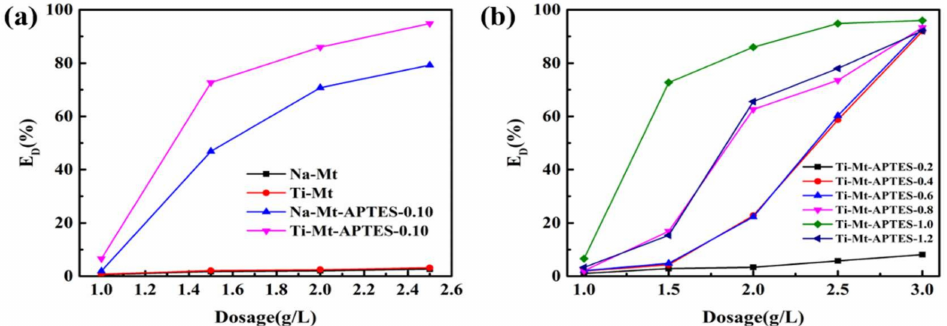
Figure 7. ( a ) Demulsification performance of Na-Mt, Ti-Mt, Na-Mt-APTES-0.10, and Ti-Mt-APTES-0.10. ( b ) Effect of the Ti-Mt-APTES dosage on demulsification efficiency at various R